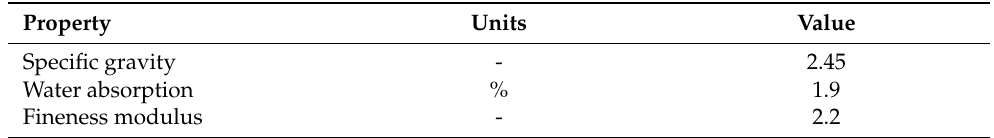
Table 2. Properties of quartz sand